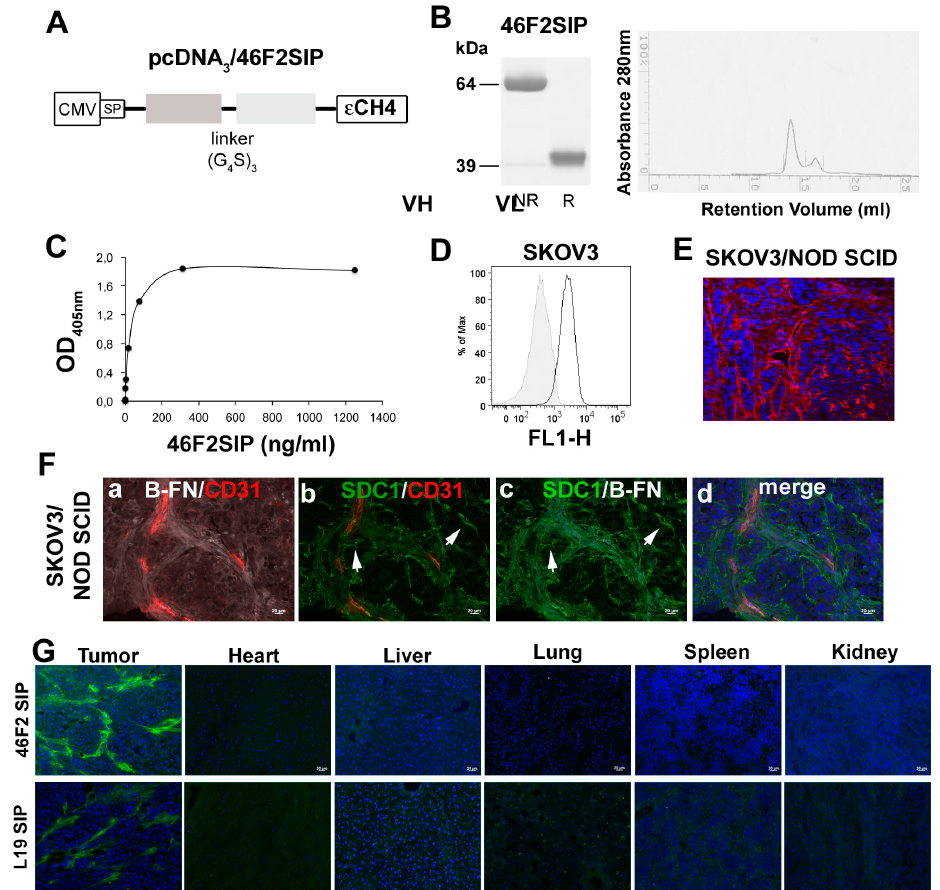
Figure 4. Characterization of 46F2SIP (small immuno protein) antibody format. ( A ) Schematic representation of anti-SDC1 46F2SIP antibody format. ( B ) SDS-PAGE analysis of 46F2SIP in no reduction (NR) and reduction conditions (R) (left panel) and profile of elution of the antibody